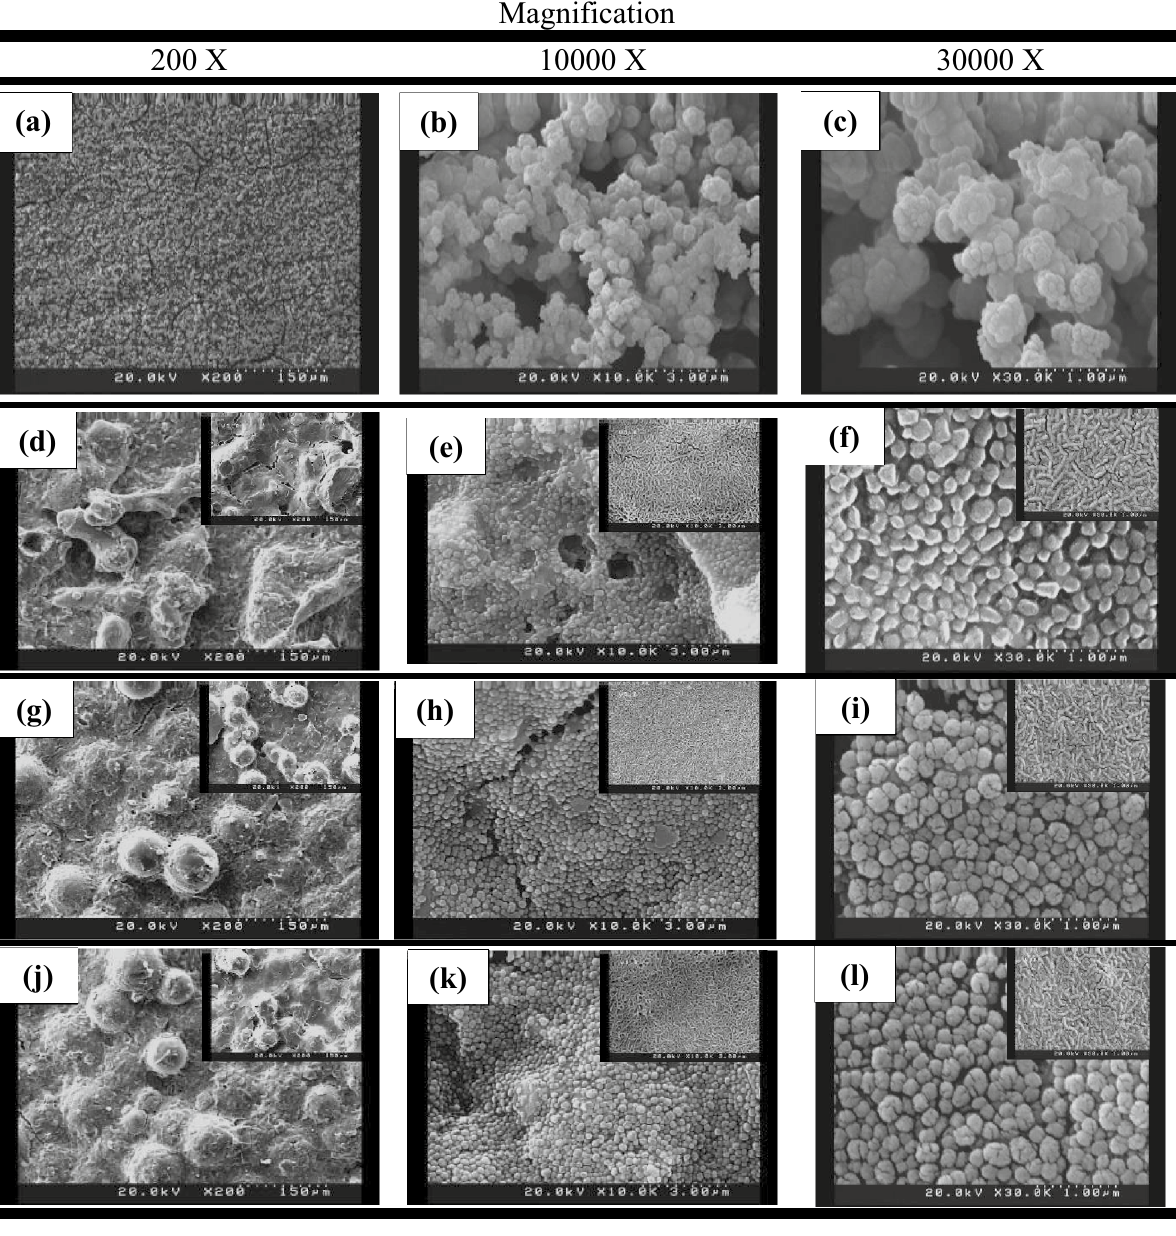
Figure 3. SEM images of nanosilica and PTFE coatings on MS substrate. ( a – c ) Nano silica coating 46 . ( d – l ) PTFE coatings includes morphological images of primer layer (large image), and primer and overcoat layers (small image): ( d – f ) Micro Al 2 O 3 —with nano SiO 2 , ( g – i ) Micro glass beads- without nano SiO 2 , ( j – l ) micro glass beads—with nano SiO 246